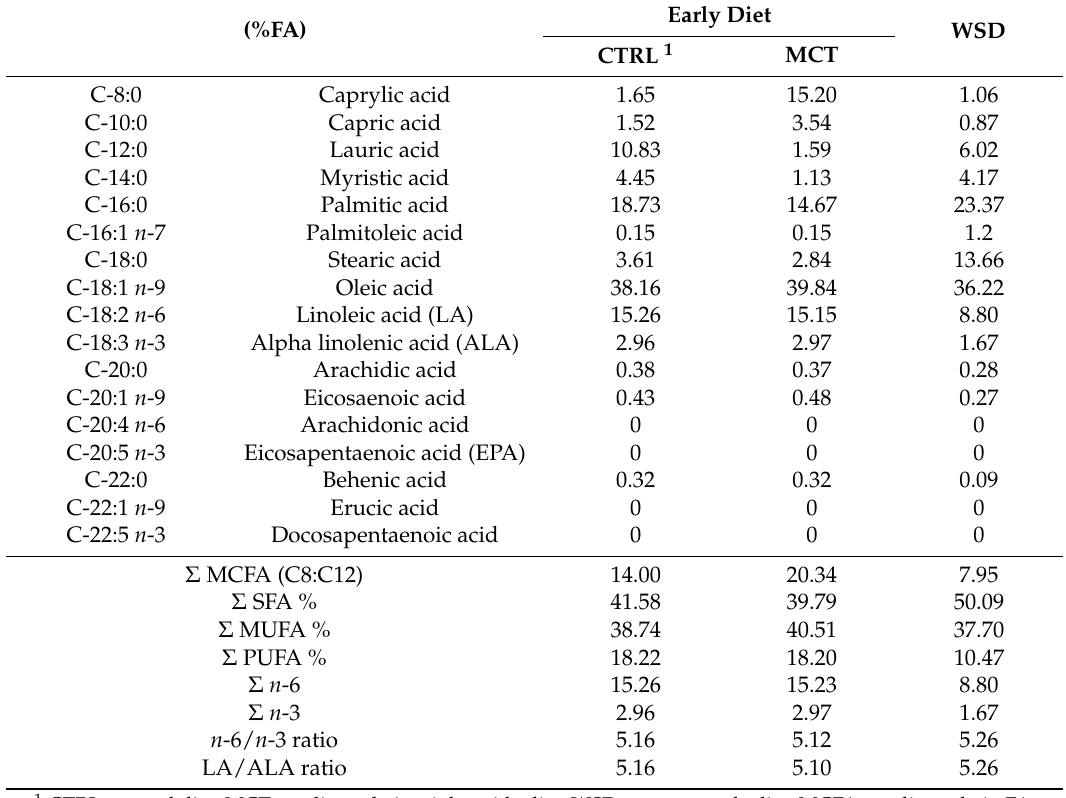
Table 1. Fatty acid (FA) composition of the experimental diets (as